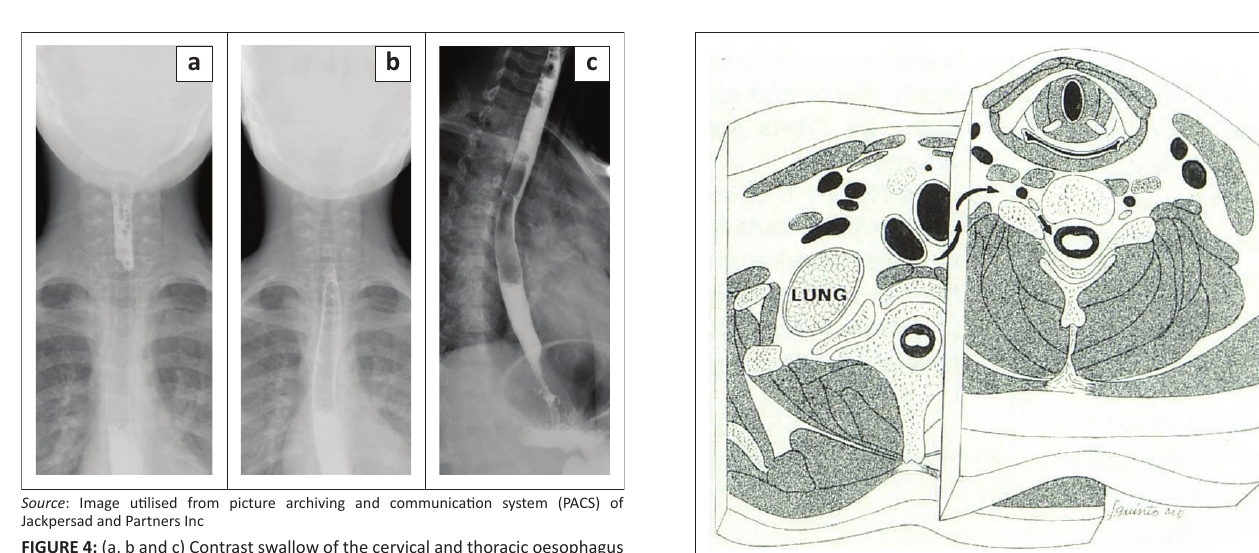
FIGURE 4: (a, b and c) Contrast swallow of the cervical and thoracic oesophagus excluded oesophageal perforation.